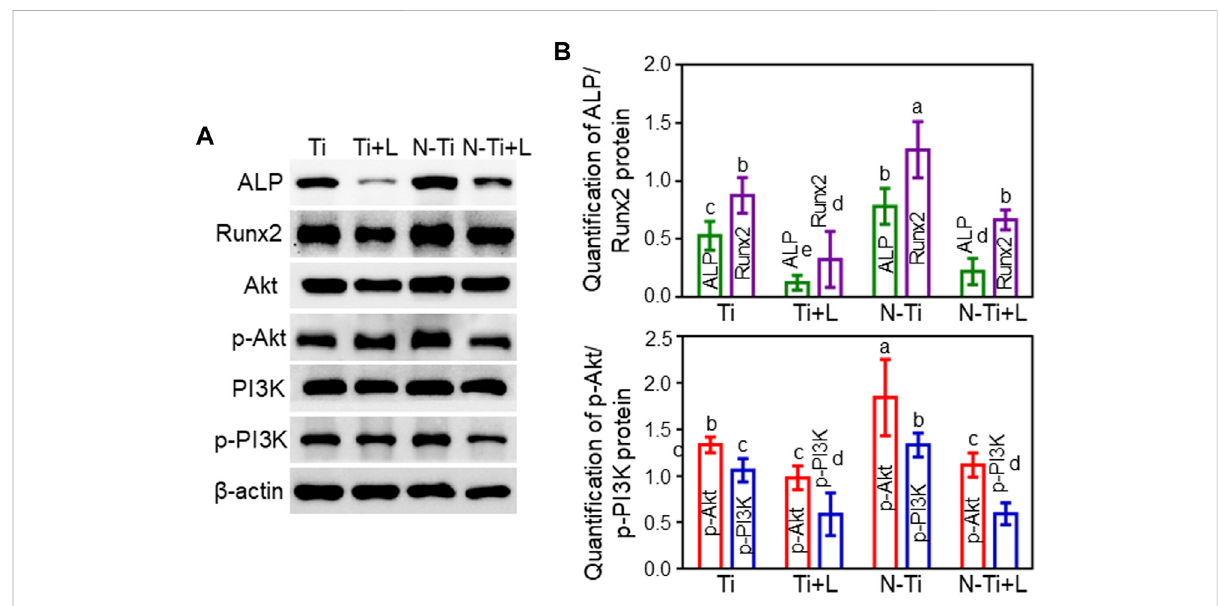
FIGURE 4 The protein expressions involved in osteogenesis and PI3K/Akt signaling pathway on Ti, Ti + L, N-Ti, N-Ti + L surfaces. (A) Western blot of ALP, Runx2, PI3K, p-PI3K, Akt, p-Akt, and β -actin protein expression of MC3T3-E1 cells after cultured on Ti surfaces for 7d. (B) Quantitative results of Western blot. Results are shown as mean ± SD; n = 4/group. Values with diverse letters are notably different ( p <